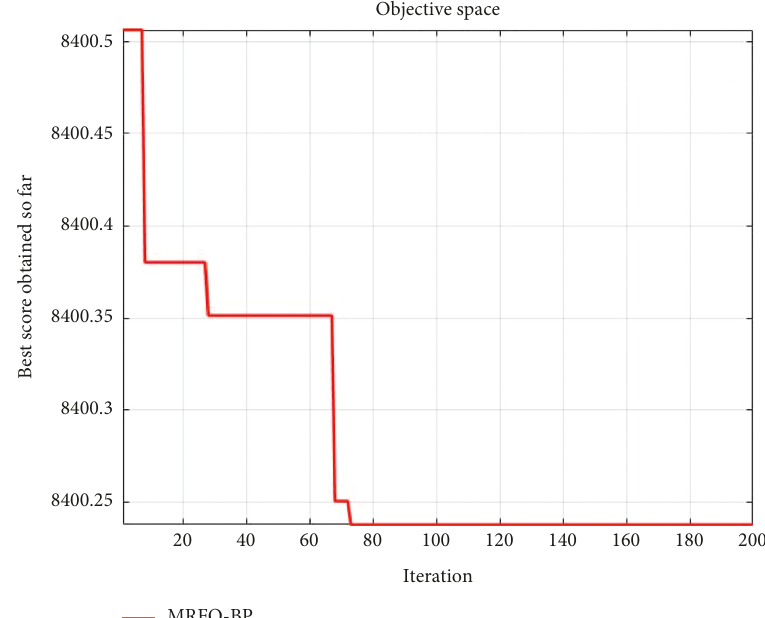
Figure 12: Historical optimal position curve of the tail of the spiral